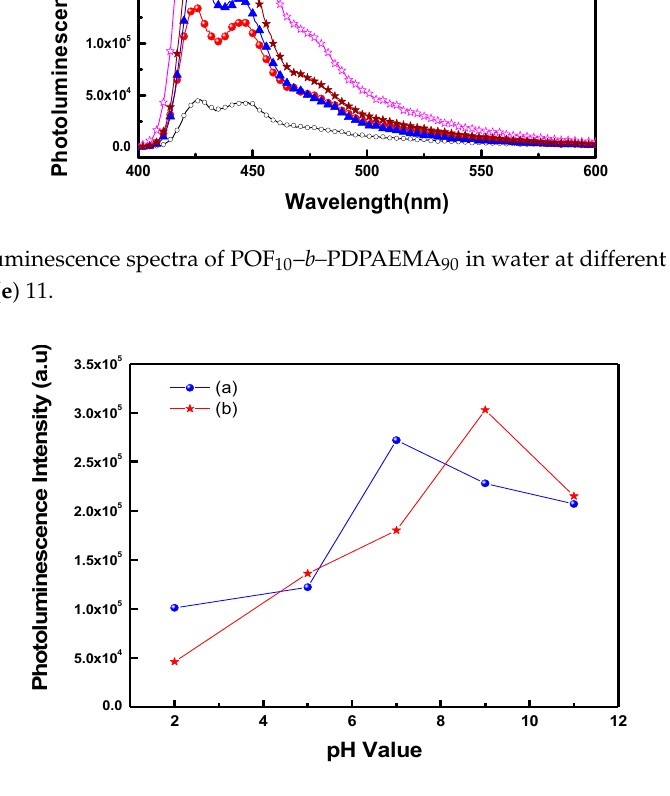
Figure 8. Variation of photoluminescence intensity of ( a ) POF 10 – b –PDPAEMA 197 and ( b ) POF 10 – b –PDPAEMA 90 with different pH levels.